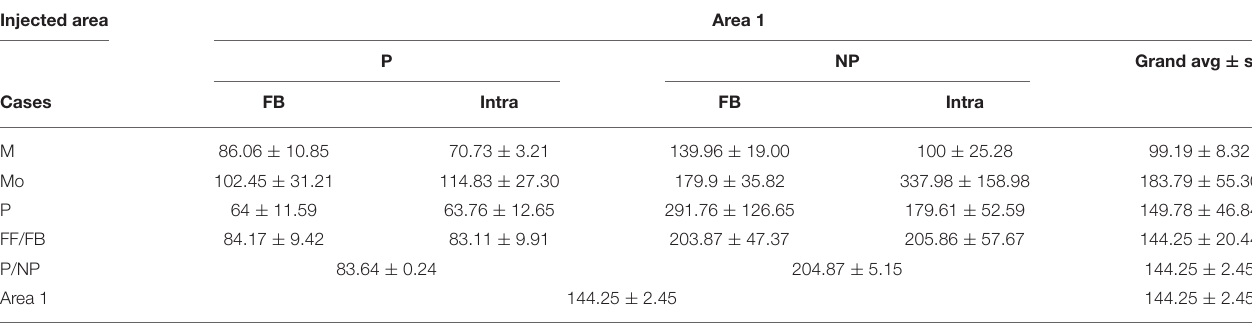
TABLE 6 | The length (mean ± SD) of the reconstructed axonal segments of the different pathways labeled by area 1 injection. Injected